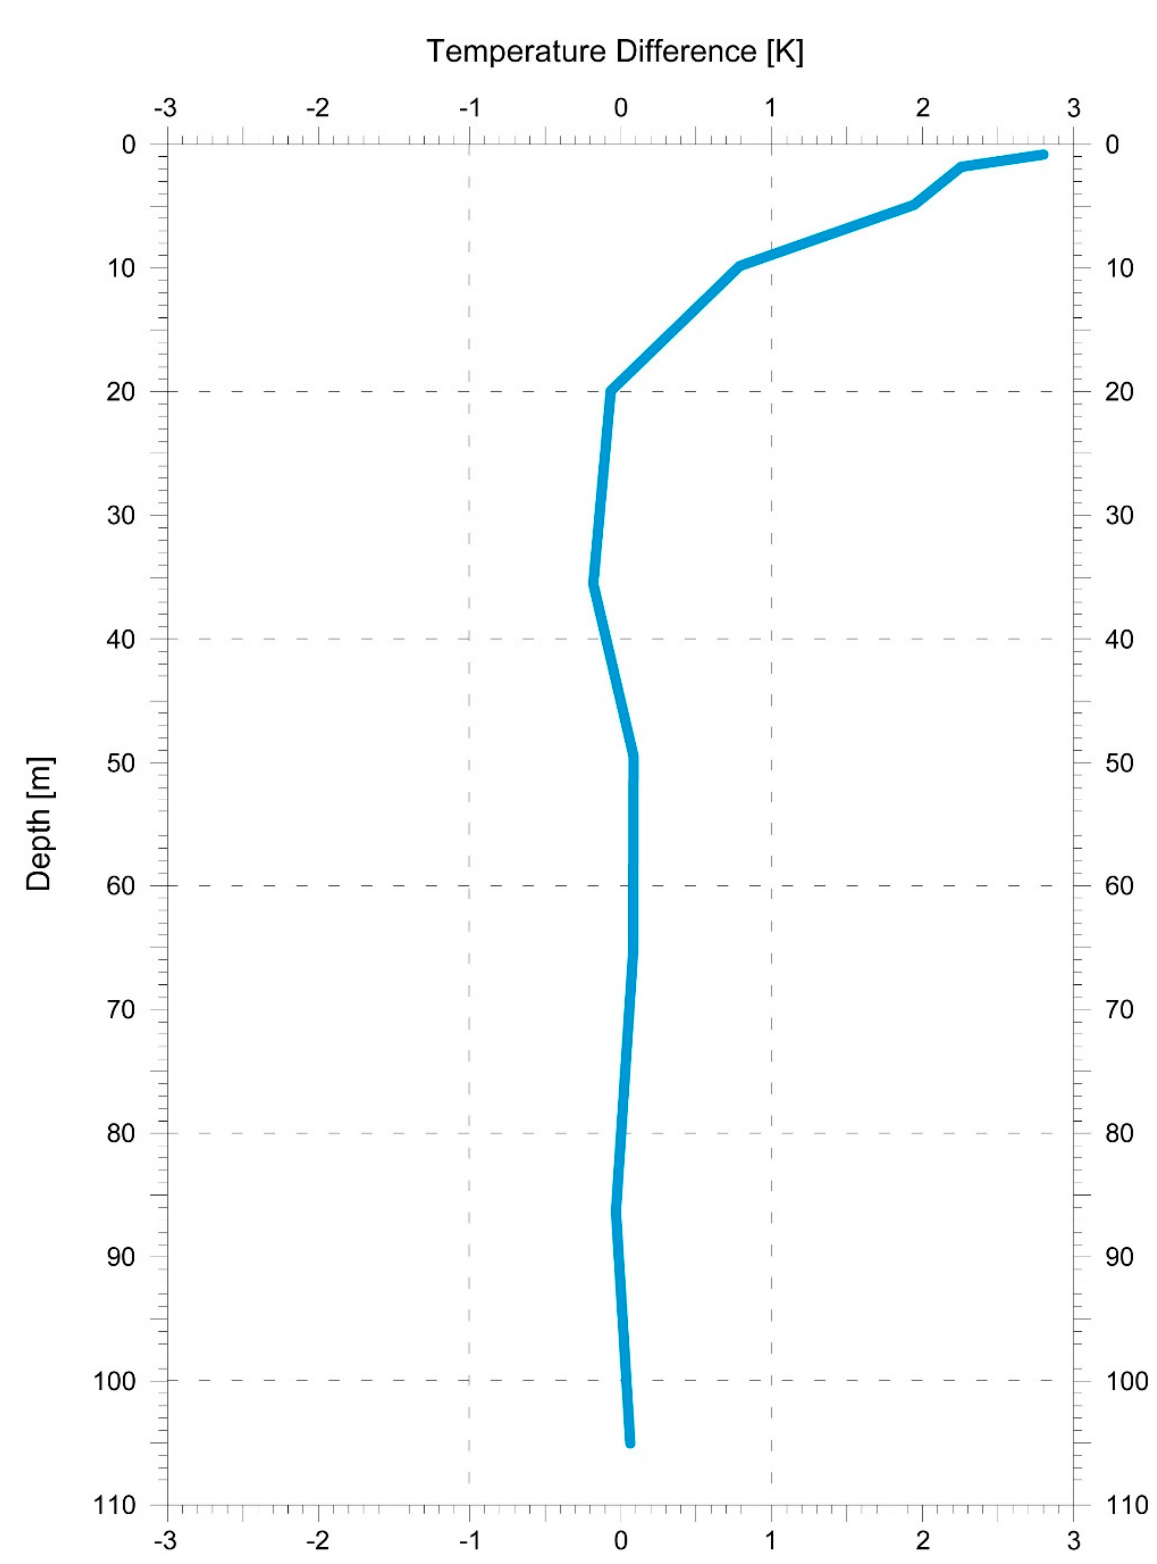
Figure 6. Difference in the measured and predicted ground temperatures (measured minus calculated values) in 0.5 m distance from the BHE after 12 years of operation. The deviations were generally within measurement error ( ± 0.1 K). Data from [5] are plotted. For details, see text.